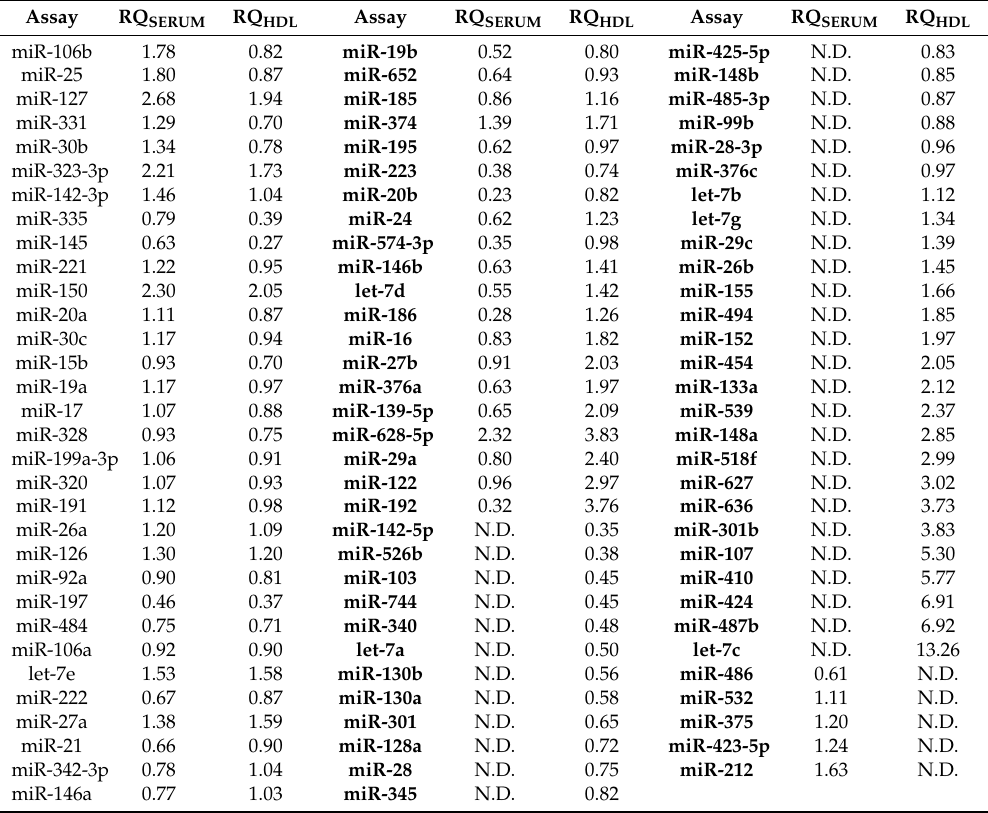
Table A2. RQ Values from Figure 1 of CRF (top) and hemodialysis patients